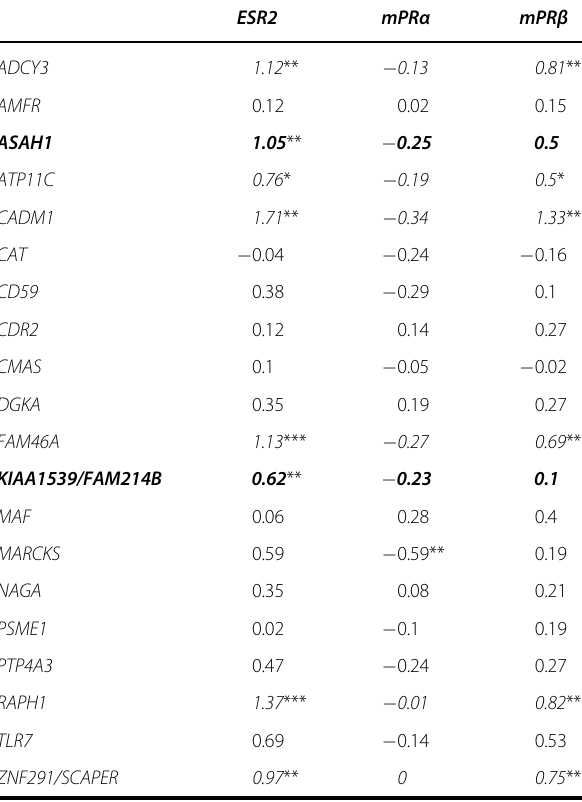
Estimates and signi fi cance are obtained from separate linear regression models. * p